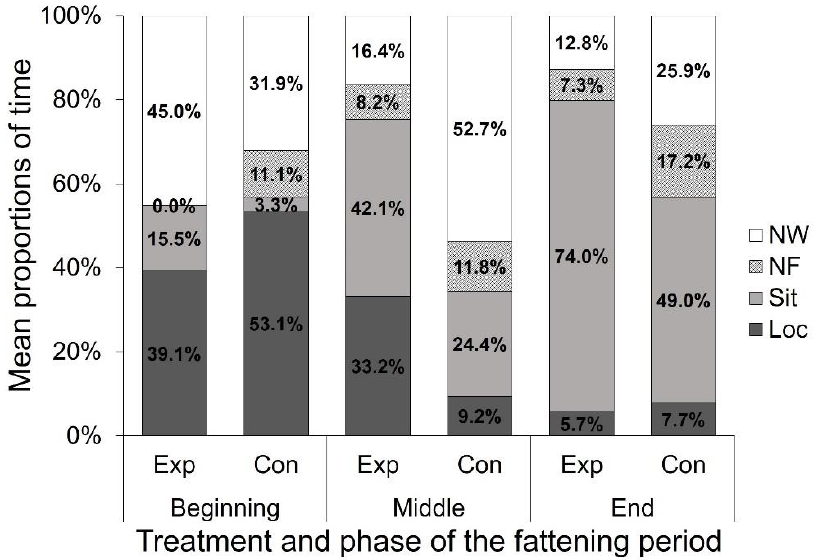
Figure 6. Mean proportions (%) of the behaviors Loc (locomotion), Sit (sitting inactive), NF (located near the feeding trough), and NW (located near the waterline) of the total time focal animals spent in the observed area at the different phases of the fattening period on the perforated floor (Exp) and in the control area (Con).